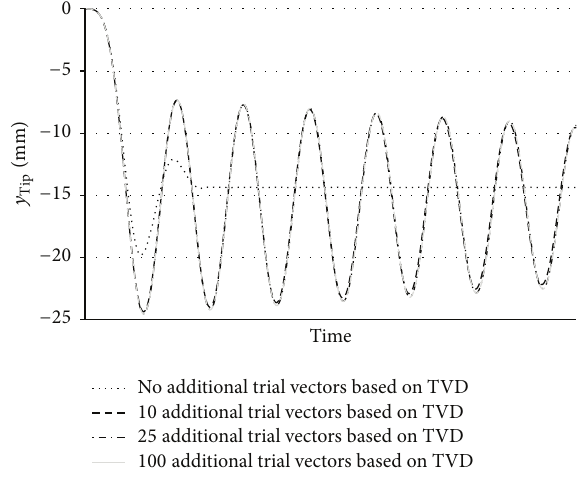
Figure 11: Tip deflection in y direction.